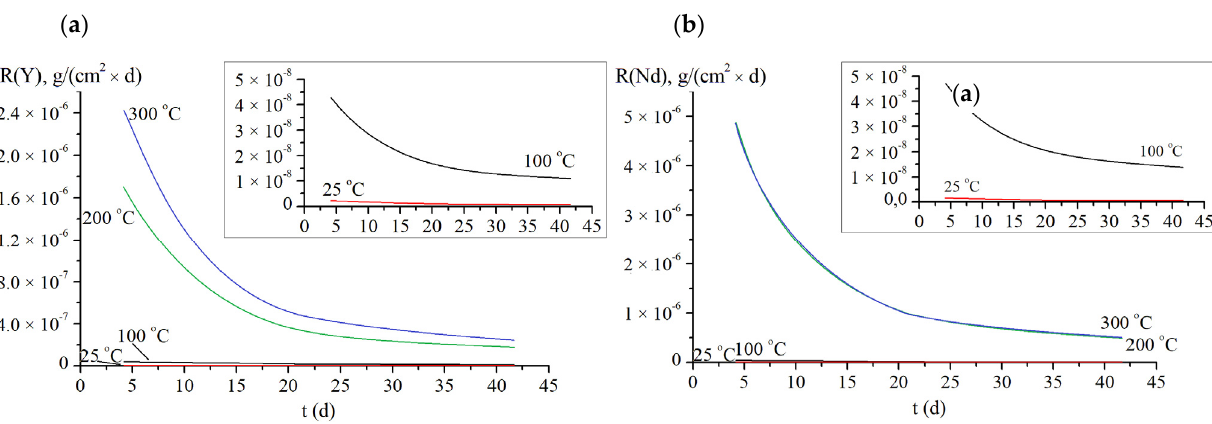
Figure 6. The leaching rate R i vs the time t for Y ( a ) and Nd ( b ). Table 1. Minimum achieved leaching rate of cations.